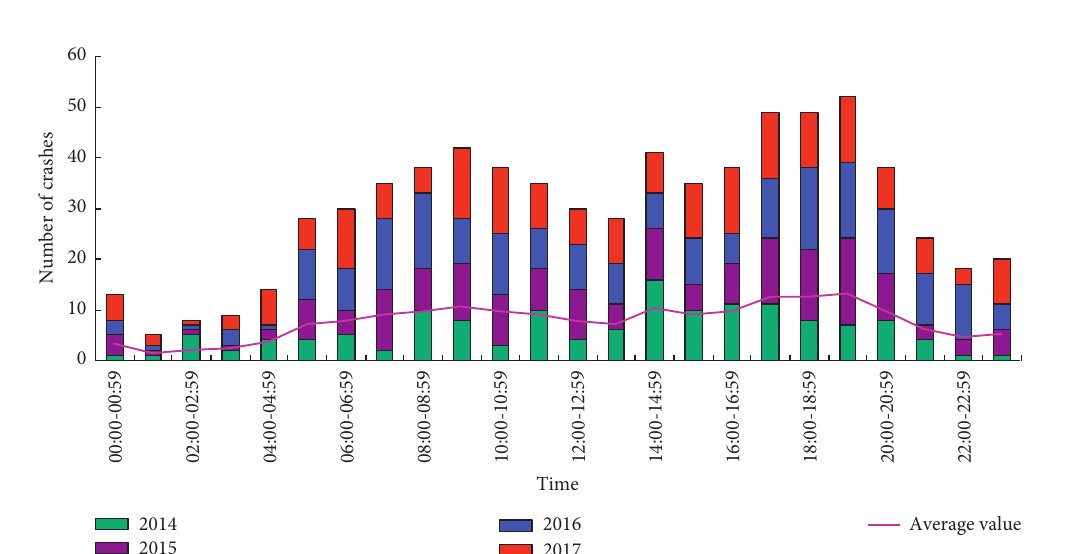
Figure 3: Temporal characteristic of traffic crashes in the rural-urban fringe.